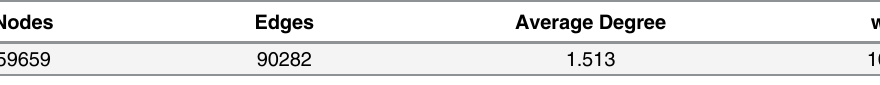
Table 1. Statistics of Data Set from DBLP.